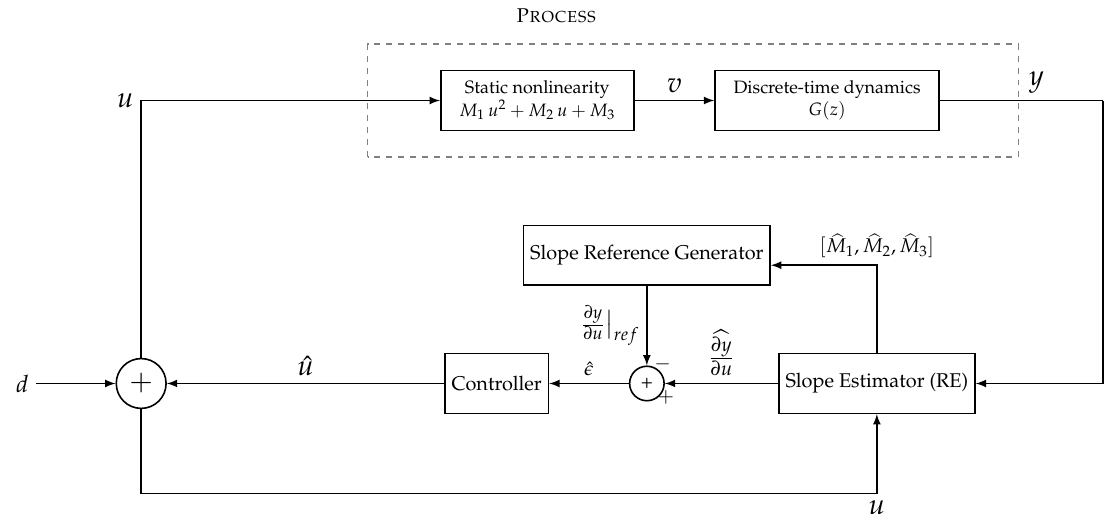
Figure 6. Block-oriented recursive extremum seeking control strategy - reproduced with permission (with slight modifications) from